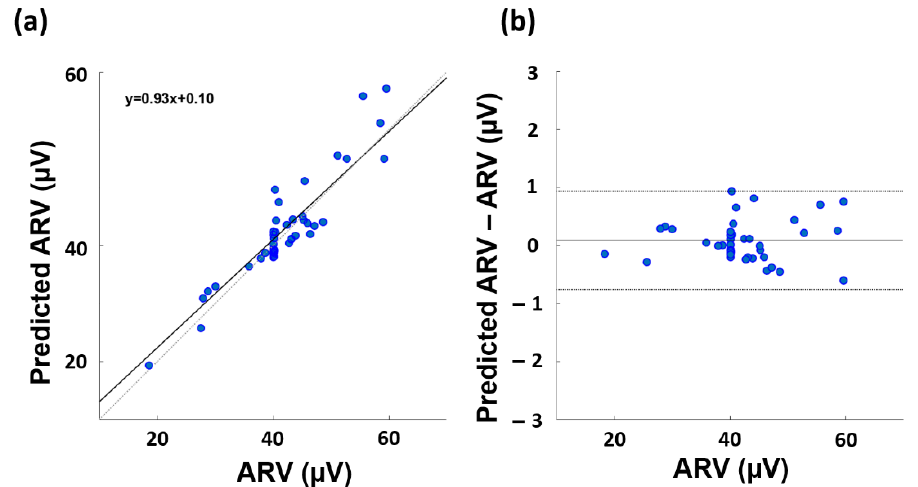
Figure 4. Correlation plot ( a ) and the Bland – Altman plot ( b ) associated to the performance of the Gaussian model developed to estimate the ARV.